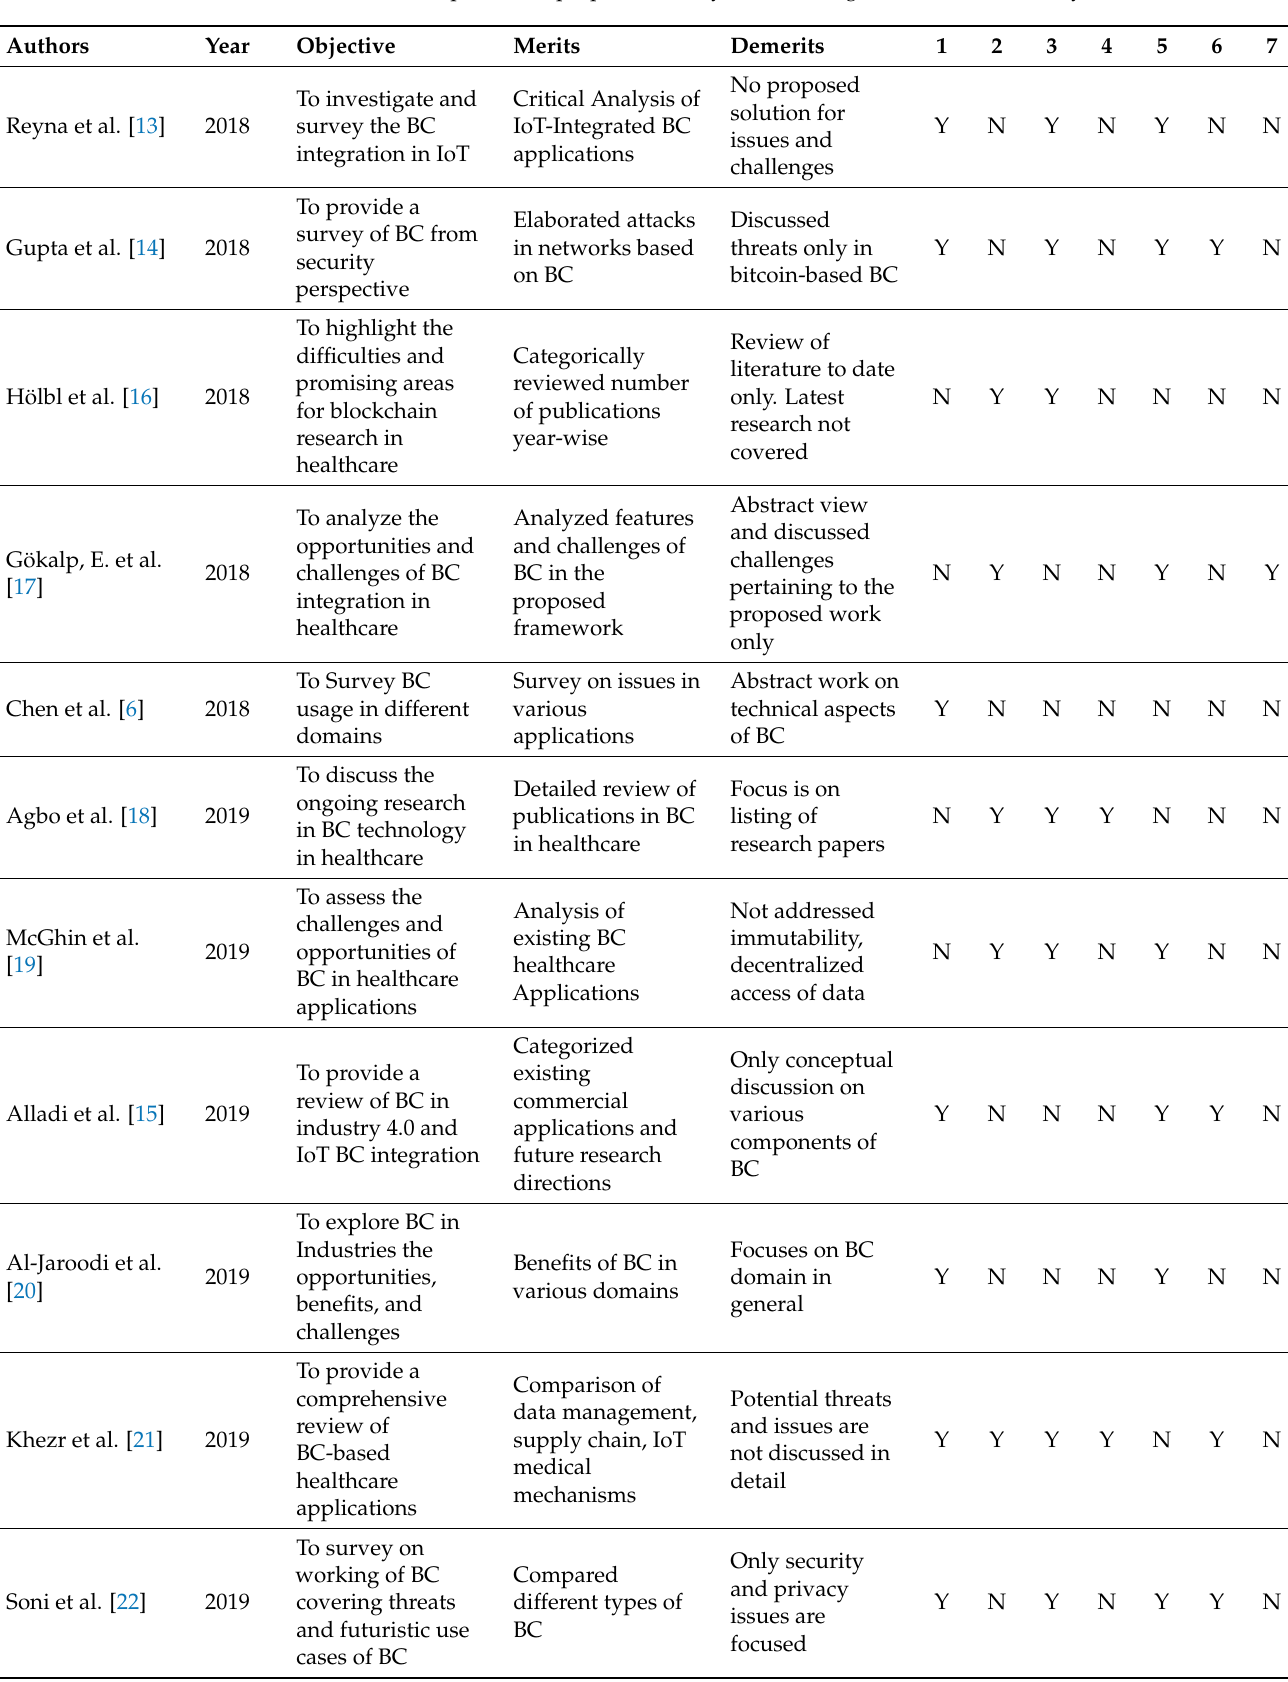
Table 1. Comparison of proposed survey with existing state-of-the-art